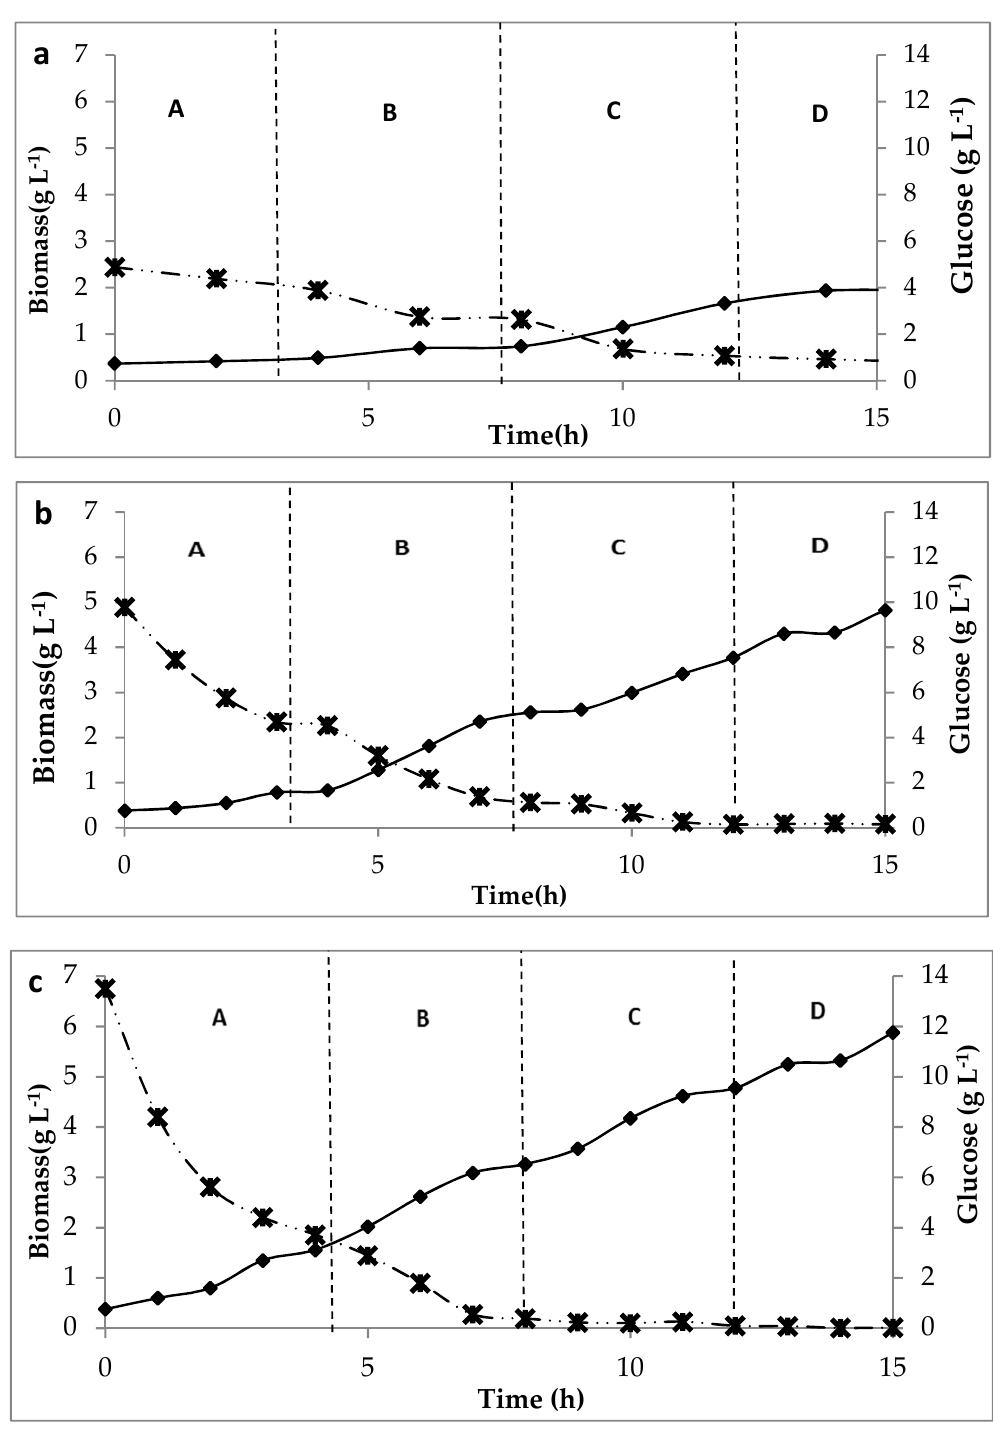
Figure 4a—cdemonstrates the relationship between biomass development and glucose consumption in the MBR for three different feed glucose concentrations, 5, 10 and 15 g L − 1 ) and four permeation rates (Zones A-D, 4, 8, 16, 32 L h − 1 ) at each feed concentration. For all the concentrations; the consumption of glucose increased while, at the same time, the concentration of biomass increased.